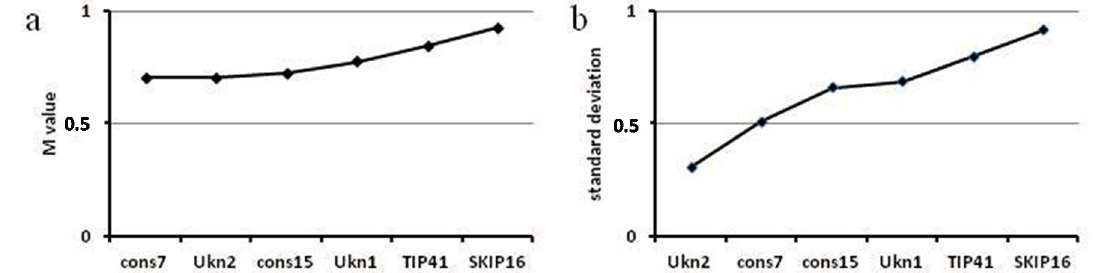
Figure 4. Ranking of G. max candidate reference genes for stability by the algorithms geNorm ( a ) and NormFinder ( b